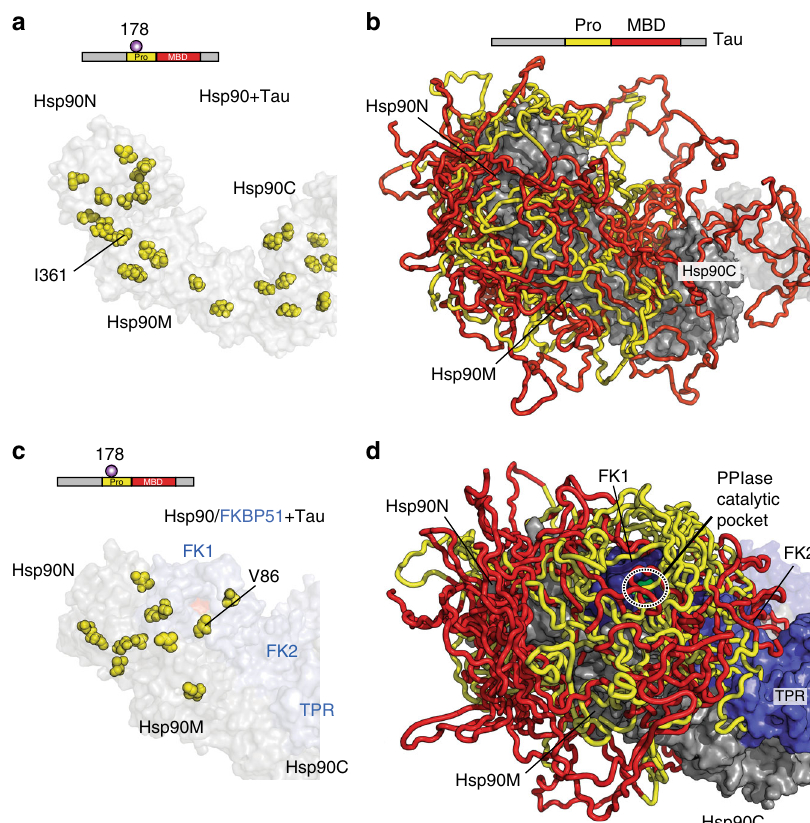
Fig. 5 Tau ’ s Pro-rich region targets to the catalytic site in the complex. a , c Isoleucine residues (yellow spheres) in Hsp90, which experience paramagnetic broadening by Tau tagged with MTSL at position 178 in the Hsp90/Tau complex ( a ) and the Hsp90/FKBP51/Tau complex ( c ). Hsp90 dimer is colored in gray, and FKBP51 in blue. Tau ’ s domain organization is shown on top. b , d Representative ensembles of Tau conformations bound to Hsp90 ( b ) and the Hsp90/FKBP51 complex ( d ), which are in agreement with experimental intermolecular contacts. Twelve lowest-energy conformers are shown. Tau ’ s proline-rich region (yellow) is targeted to the PPIase catalytic pocket of FKBP51 in the Hsp90/FKBP51/Tau complex. Tau ’ s microtubule-binding domain is colored red. For clarity, Tau regions outside of the proline-rich domain and the MBD, which contribute little to the interaction, are not